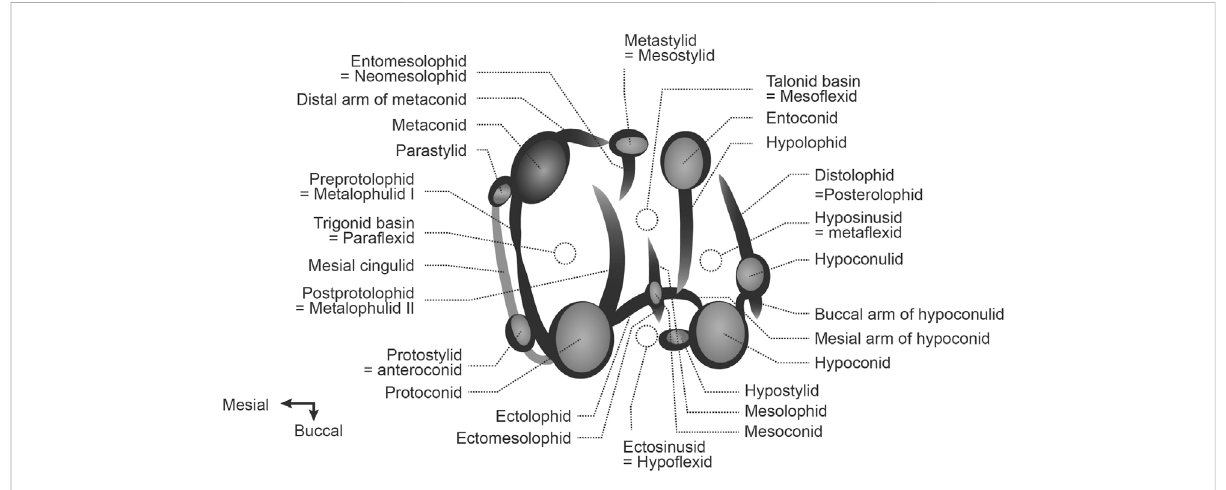
FIGURE 2 Dental terminology used for description and